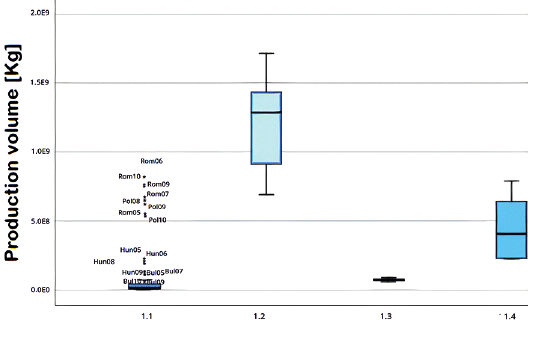
Figure 6. Box diagram of the pre-crisis production variable according t o the clusters of the second two-stage clustering level (source: own elaboration)